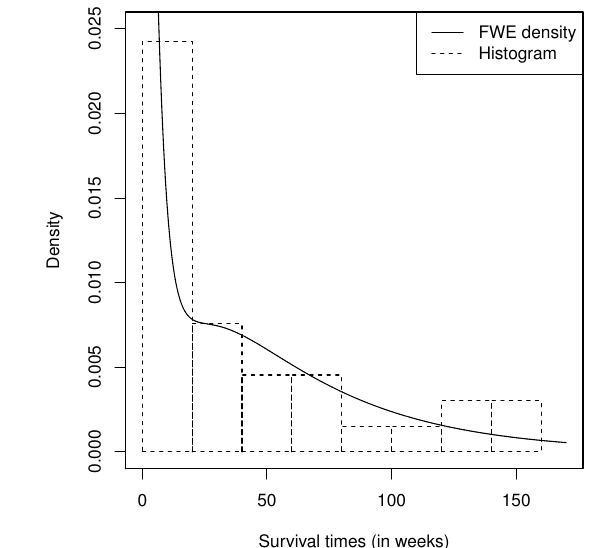
Figure 7. Fitted density plot of the FWE distribution for survival times data.